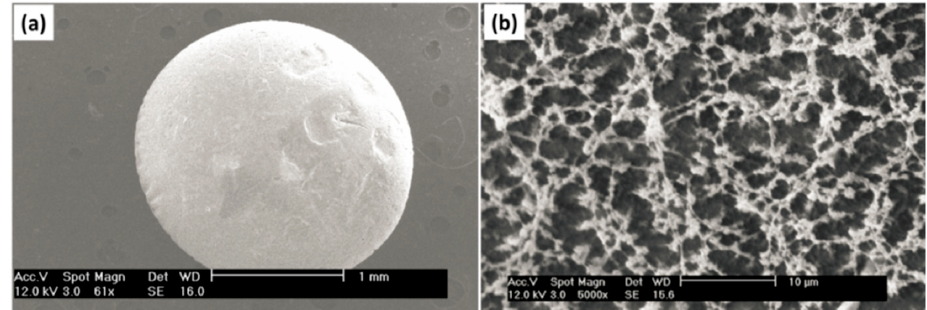
Figure 9. SEM micrographs of cellulose aerogel prepared from 5%Avicel/8%NaOH/water solutions coagulated in 10% H 2 SO 4 bath: ( a ) cellulose aerogel bead and ( b ) its cross-section. The pictures were adapted from the Thesis of Dr. R. Gavillon, CEMEF, Mines Paris Tech; reproduced with permission from Reference [151].